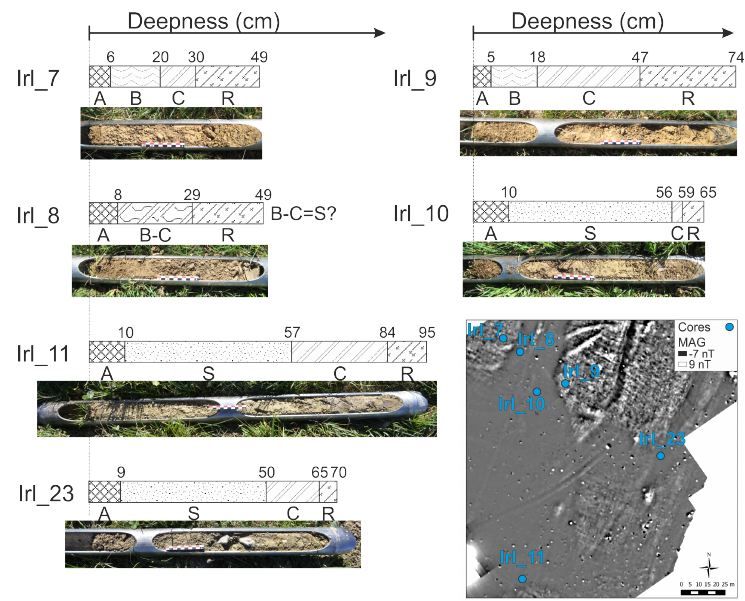
Figure 12. Detail of the location and results of cores drilled in 2016 to clarify the origin of magnetic disturbance in Otegi area. The area is highlighted in the general context of Figure 6. A horizon: Topsoil; surficial organic-rich mineral layer; B horizon: Subsoil; contains lixiviated and precipitated iron oxides and illuviated clays; C horizon: Parent material; barely edaphized but fragmented rock; R horizon: Bed rock; partially weathered bedrock, marls and limestone, at the base of the soil profile; S: Sedimentary layers.